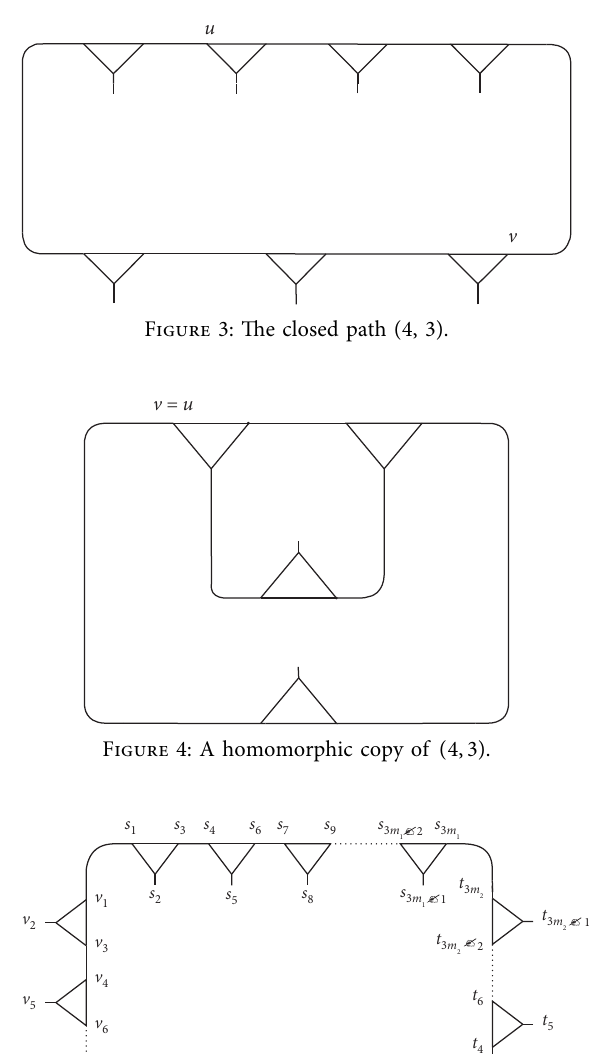
, m ,m , m ) , where m 1 2 3 4